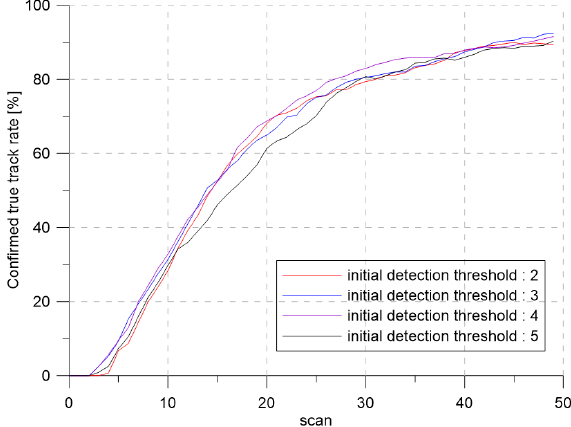
Figure 13. The confirmed true track rate according to each initial detection threshold.